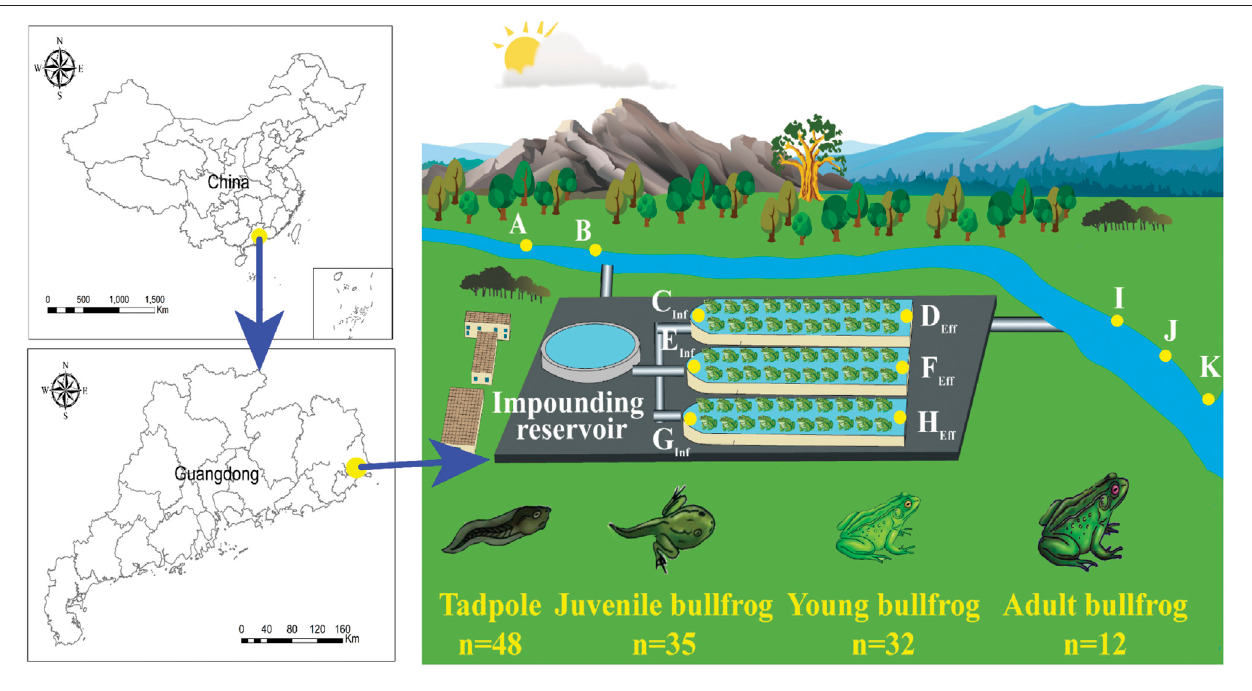
FIGURE 1 | Study area and distribution of sampling